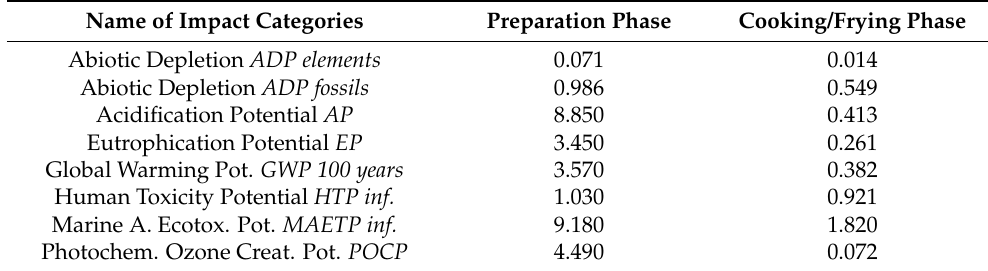
Table 2. Environmental impacts in the preparation and cooking/frying phases of the examined product in nanograms (functional unit: one portion product). Normalisation reference: CML 2016, EU 25 + 3, year 2000, excluding biogenic carbon. Weighting method: thinkstep LCIA Survey 2012, Europe, CML 2016, excluding biogenic carbon).